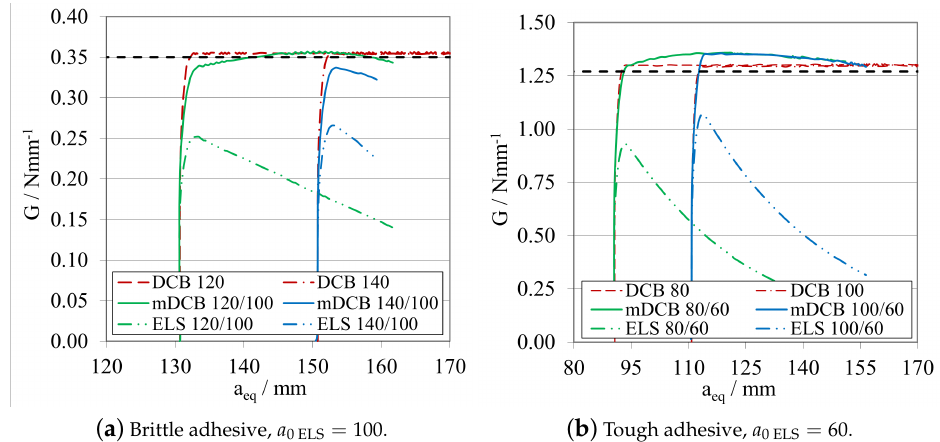
Figure 25. R-curves related to fixed a 0 ELS , dependent on the adhesive, and a 0 ELS < a 0 mDCB , compared against the correspondent standard DCB, analysed through the novel mDCB CBBM data reduction scheme. Black dashed line represents the input G IC